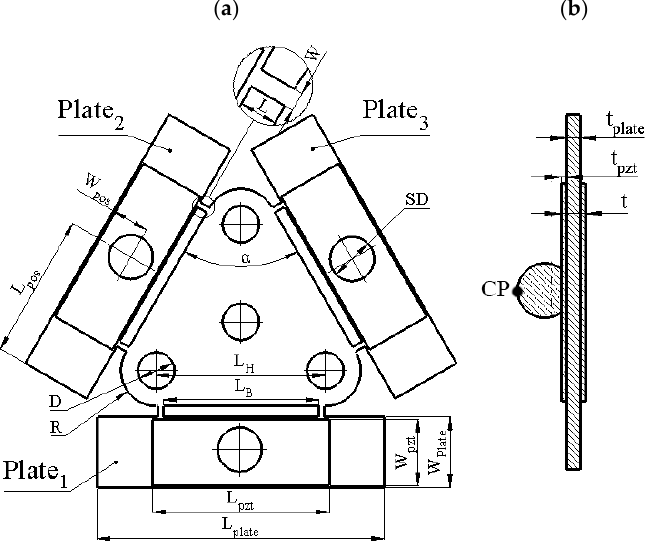
Figure 2. Sketch of the platform; ( a )—bottom view; ( b )—section view of the bimorph plate with the spherical contact; CP—contact point. Table 1. Geometrical parameters of the platform.